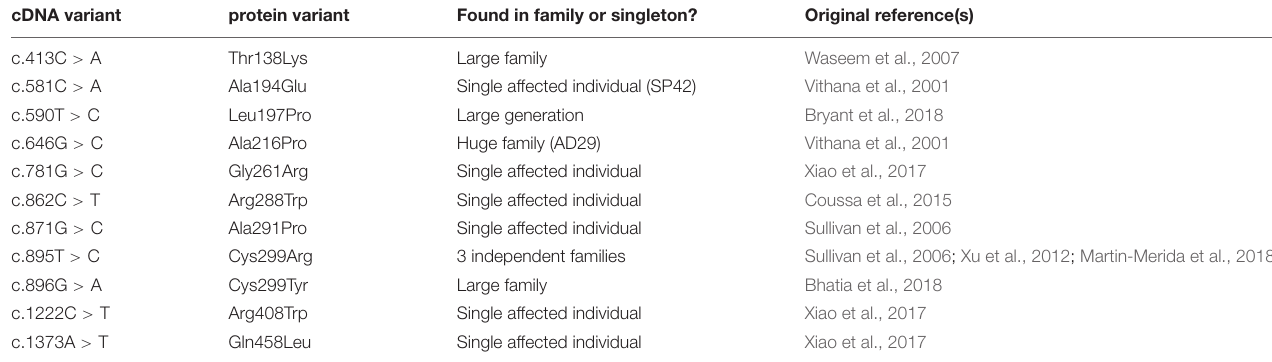
TABLE 1 | Summary of published missense mutations in PRPF31 .